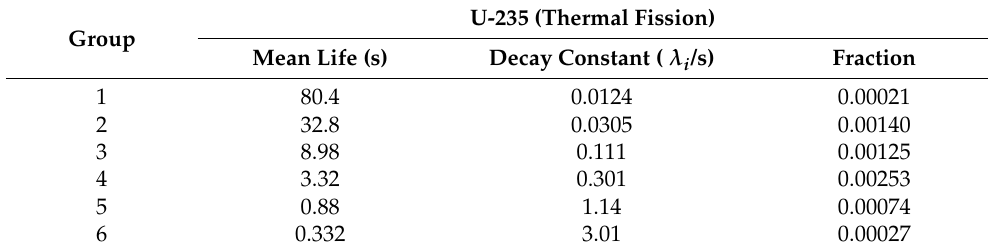
Table 3. Delayed neutron